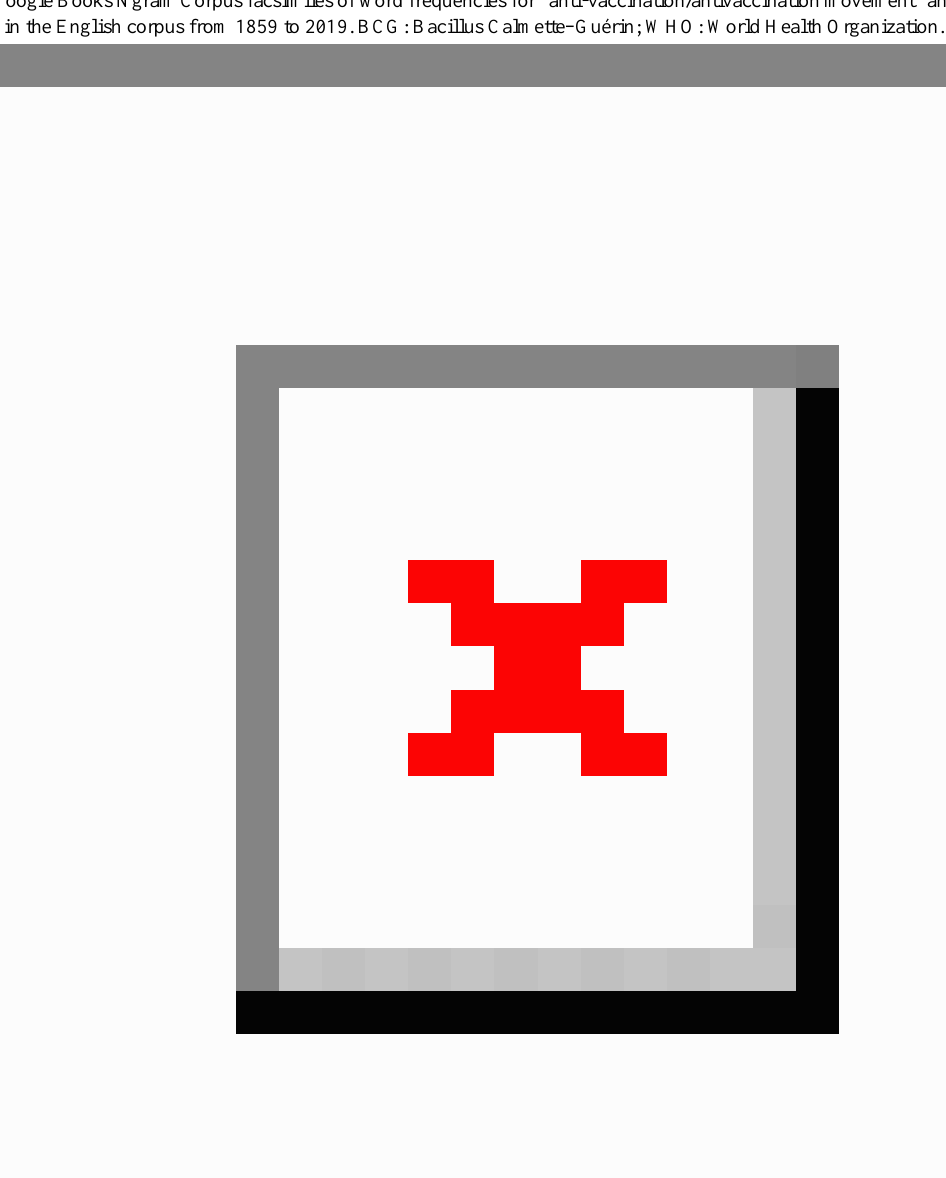
Figure 6. Google Books Ngram Corpus facsimiles of word frequencies for "anti-vaccination/antivaccination movement" and